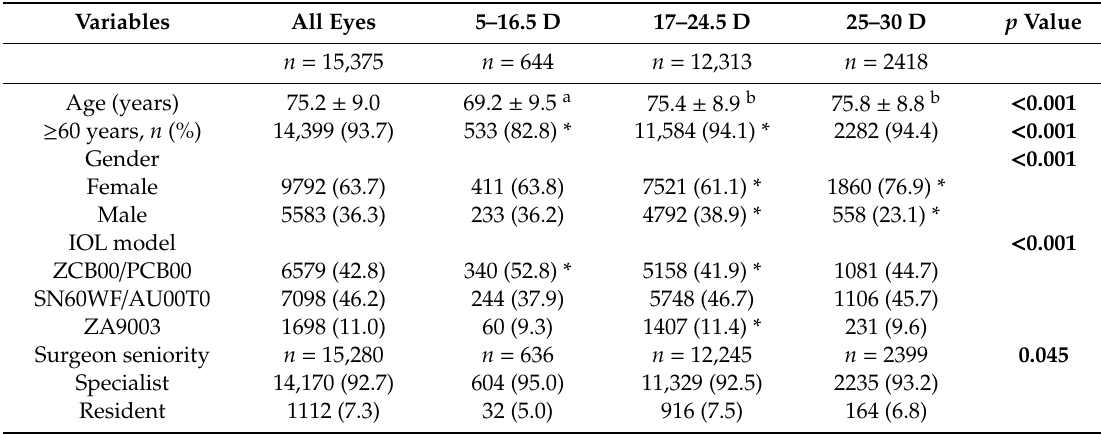
Table 1. Baseline demographic and surgical characteristics.